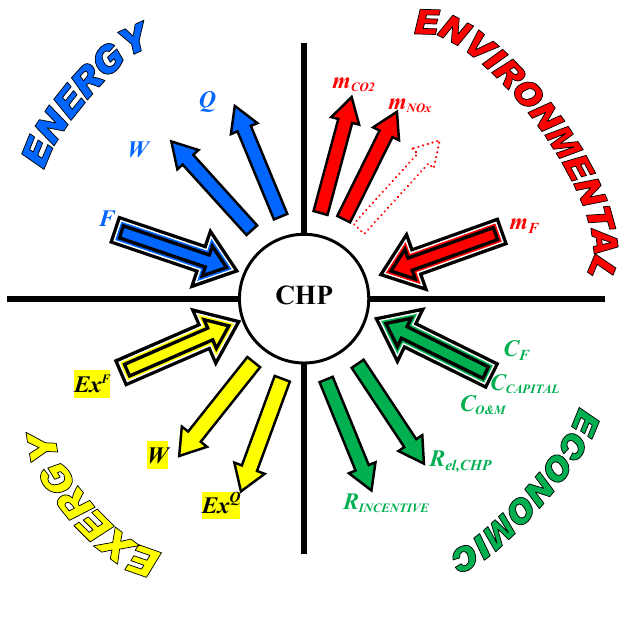
Figure 1 . The main quantities concerning the energy, exergy, emission and economic balances used to analyse the CHP (see the nomenclature for the meaning of the